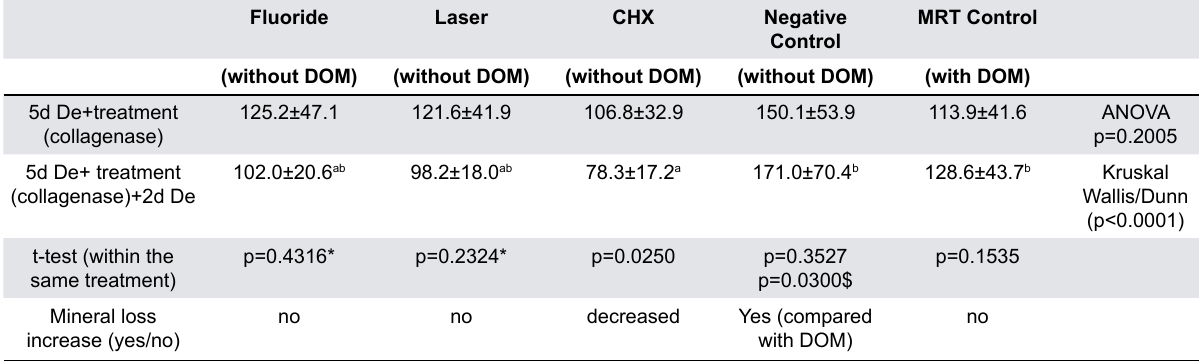
Figure 3- Representative MRT pictures of an enamel sample per group, including DES 1 (1st demineralization) and DES 2 (2nd demineralization after treatment) areas Table 2- Lesion depth (LD, μm) of dentin after different experimental Fluoride